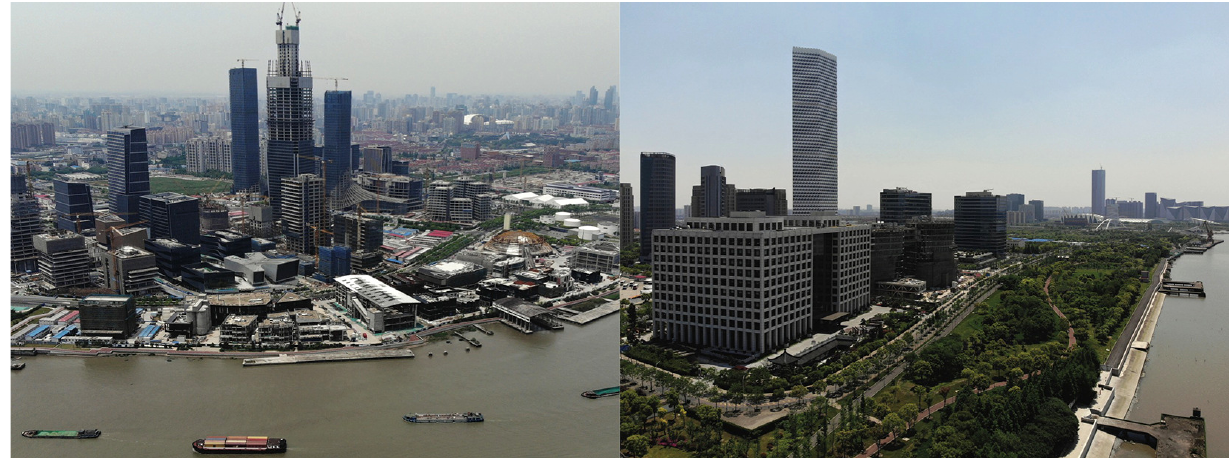
Figure 5. Emerging urban megaprojects AI Town (left picture) and Houtan (right picture), with super‐tall landmarks. Source: Author (March